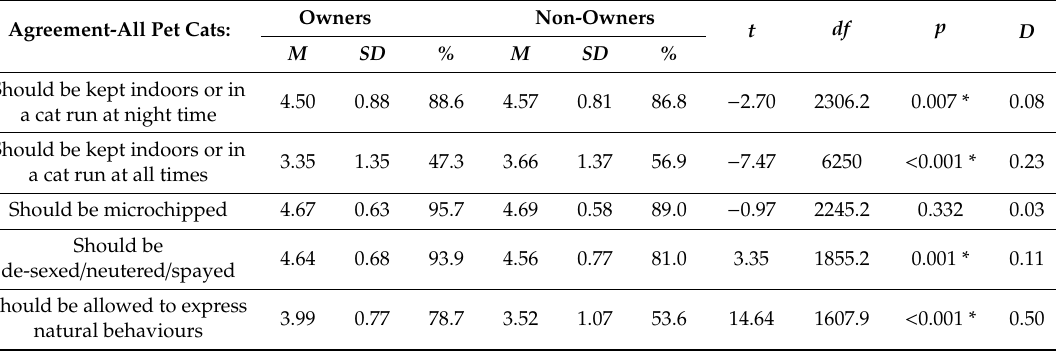
Table 2. Means ( M ), standard deviations ( SD ), percentage (%) of respondents who either agreed or strongly agreed with specific statements and t -test results comparing cat owners and non-owners on a series of responsible cat management variables. Cohen’s d (d) e ff ect sizes are also presented. Items were measured on a 5-point Likert scale, with higher scores indicating a higher level of agreement with the